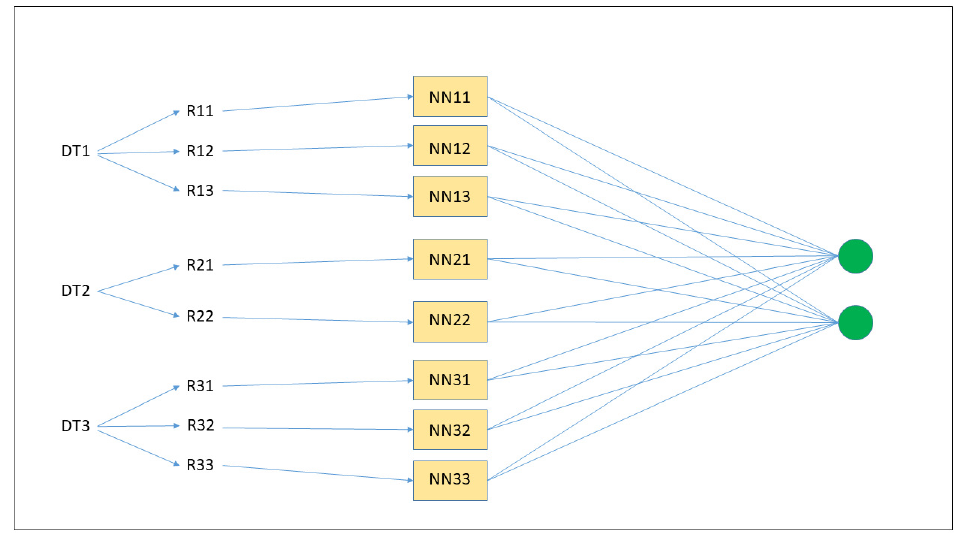
Figure 1. Transformation of an ensemble of three DTs into an ensemble of neural networks. First, from each DT, a number of rules are generated (R11, R12, etc.); second, each rule is inserted into a single neural network (NN11, NN12, etc.); third, the final classification is the result of all of the neural networks’